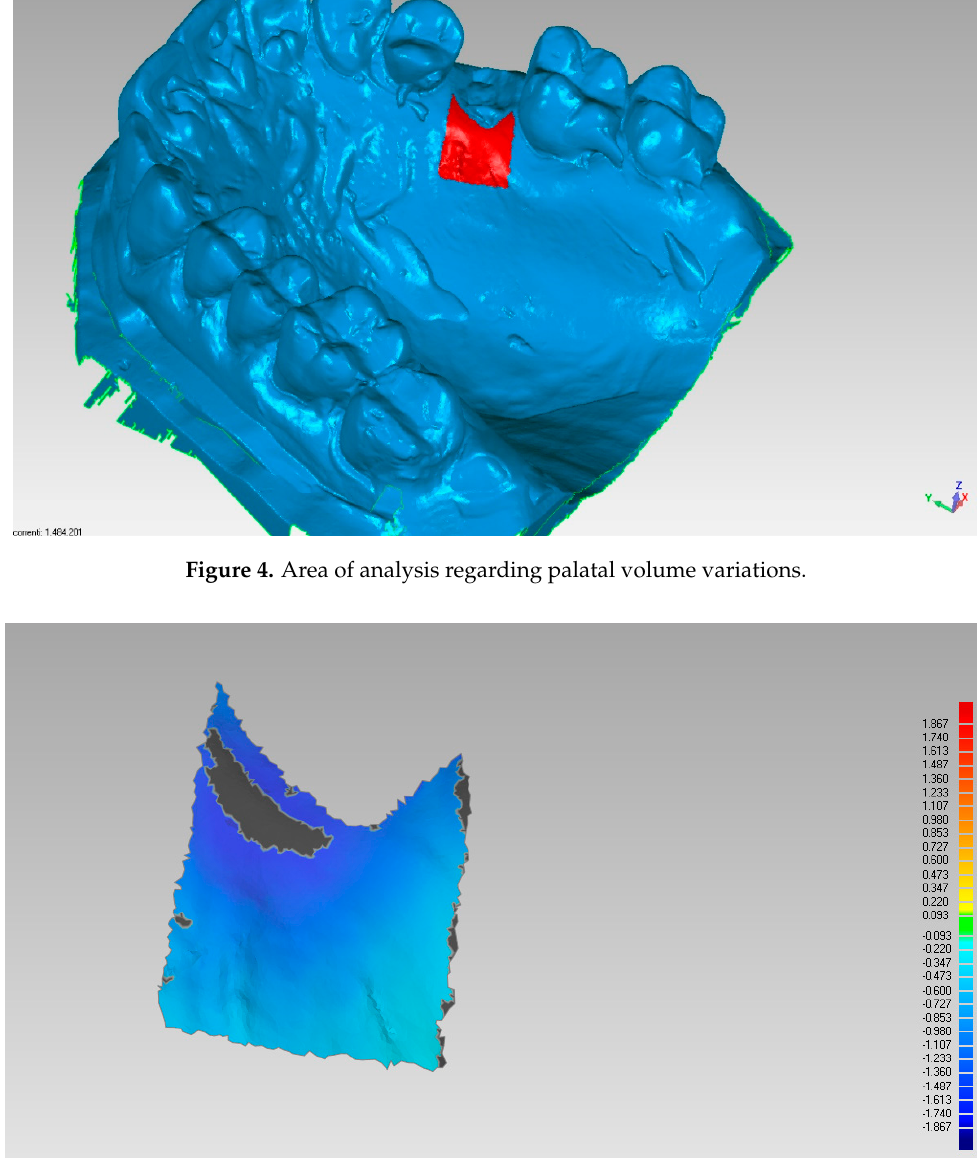
Figure 3. Superimposition of pre and post models based on the best fit of tooth surface.